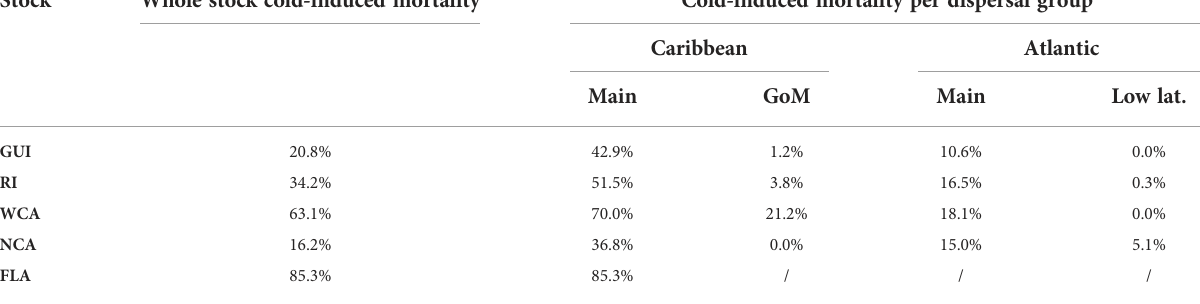
TABLE 4 Cumulated cold-induced mortality rates (at the end of the simulation) in the different dispersal groups of each stock.